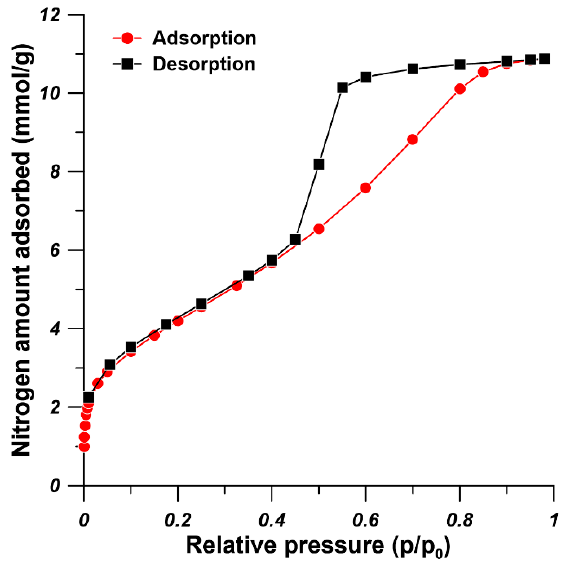
Figure 5. N 2 adsorption and desorption curves of UiO-66-NH 2 .